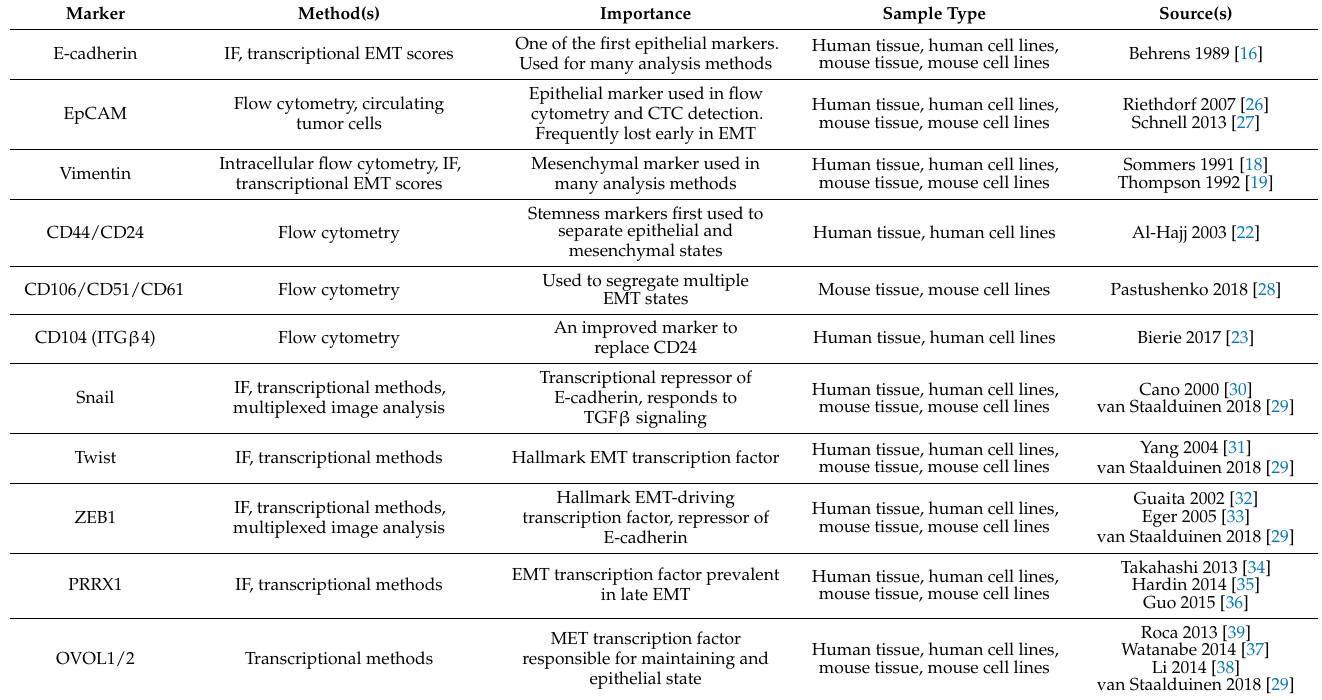
Table 1. A summary of key EMT marker proteins and their use and relevance in determining EMT